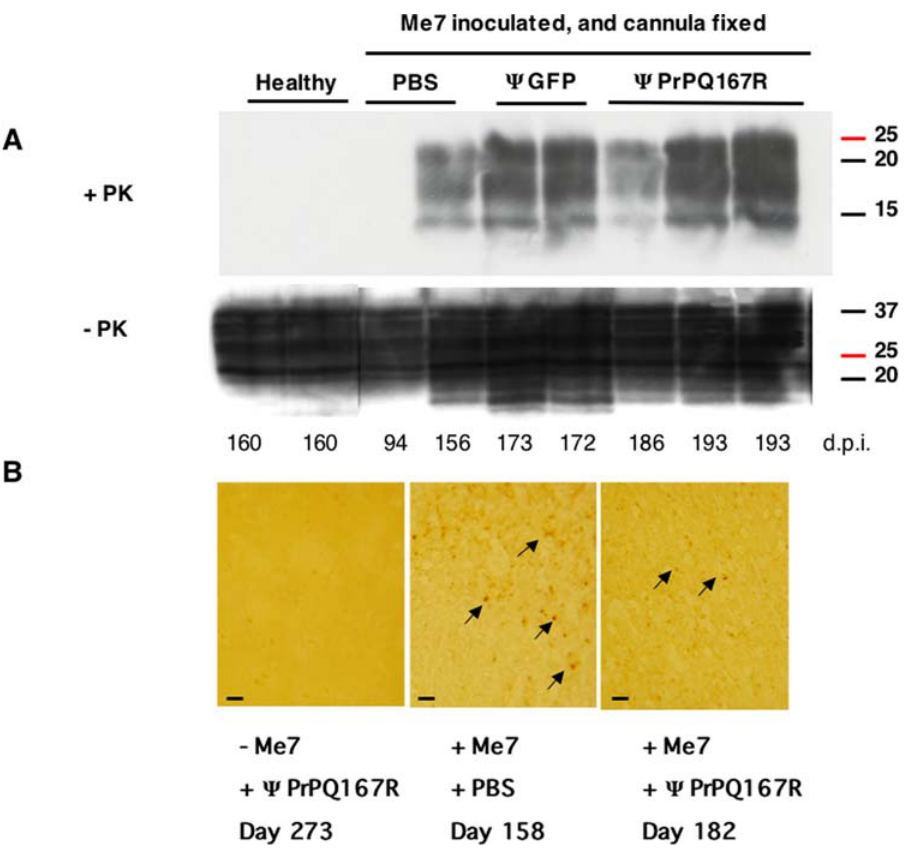
Figure 3. Analysis of PrP Sc accumulation in the brains of mice after treatment with lentiviral vectors. Immunoblot analysis of brain homogenates before and after proteinase K digestion (A). Control mice were either not inoculated with prions or were inoculated with Me7. Mice inoculated with the Me7 prion strain and implanted with a guide cannula received injections of either PBS, lentivirus carrying the GFP gene, or lentivirus carrying the PrPQ167R gene. The numbers below indicate the dates when the mice were killed in days post-inoculation with prions (d.p.i). The numbers to the right of each blot indicate the molecular mass of the protein standards in kDa. A mix of anti-PrP antibodies was used to stain blots of SDS-polyacrylamide gels. Immunohistochemical detection of PrP Sc deposits in the thalamus sections (B). The plus ( + ) and minus ( 2 ) signs indicate that the mice were or were not inoculated with the ME7 prion strain and whether they were injected with PBS or PrPQ167R virions. Tissue labelling was performed on 9 animals (3 per group). Pictures are representative of the staining observed in different animals in each group. Arrows indicate the localization of the PrP Sc deposits in the tissue sections. Bar, 6 m m.